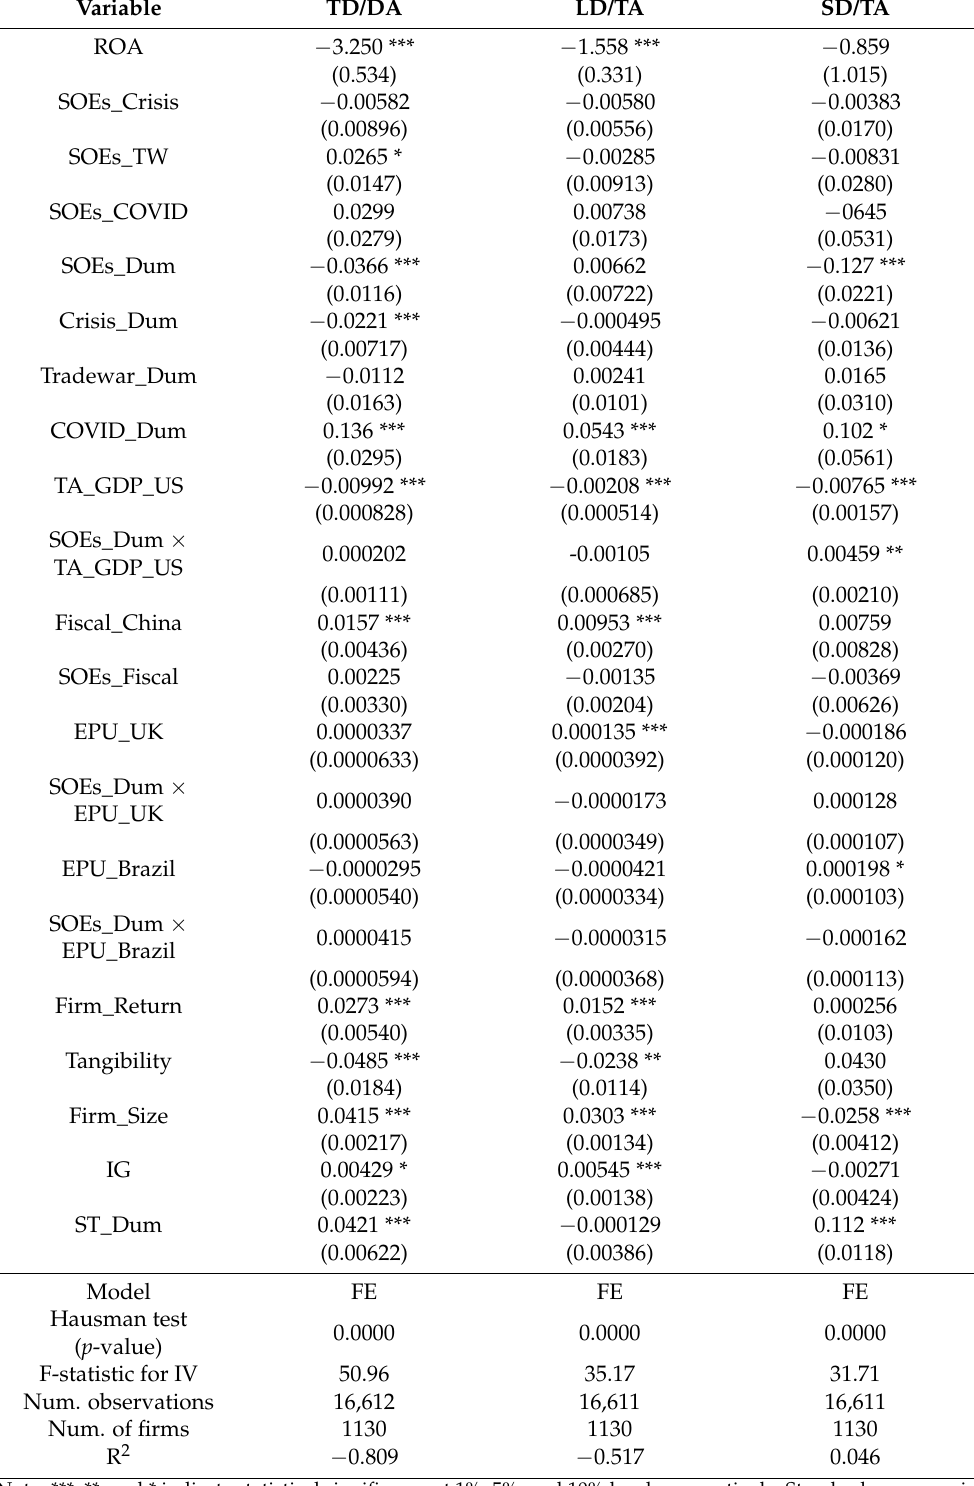
Table 9. The impacts of the Great Recession, Trade War, and COVID-19: SOEs vs.